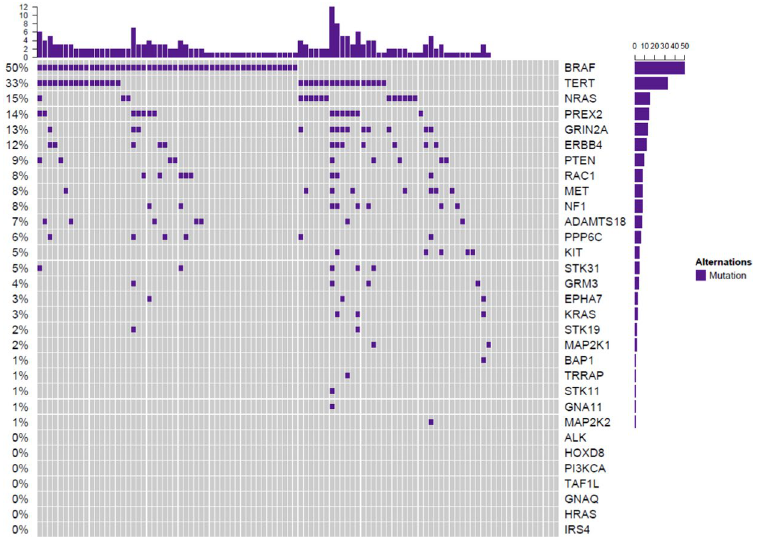
Figure 2. Frequency of somatic gene mutations. Each column represents 1 sample and each row represents 1 gene. The column on the left indicates the percentage of samples with specific gene